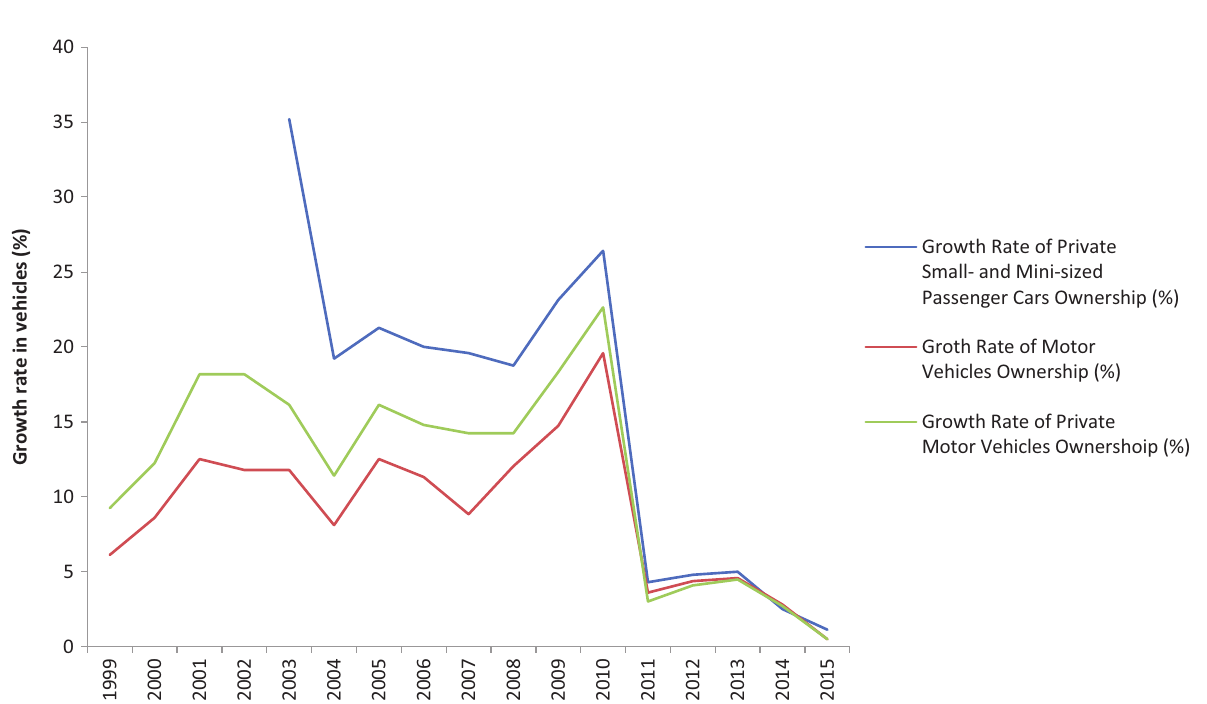
Figure 2. Comparisons of growth rate of ownership between motor vehicles, private vehicles and cars in Beijing from 1999 to 2015. Source: Compiled from data provided by the Beijing Transportation Research Centre (BJTRC, 2002–2015, 2016).